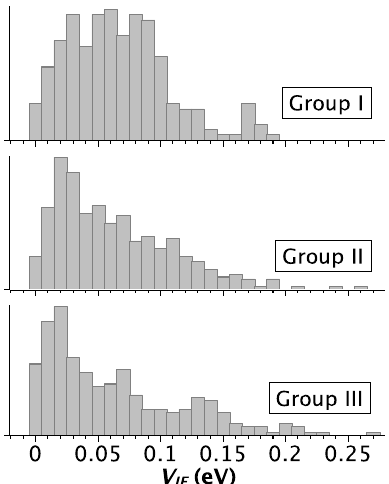
Figure 1. Distributions (normalized counts) of the computed transfer integral values for the three topology groups across the NMR structural models. The vertical axis reports the normalized counts. The group topologies are sketched in Figure 2 of Reference [9].